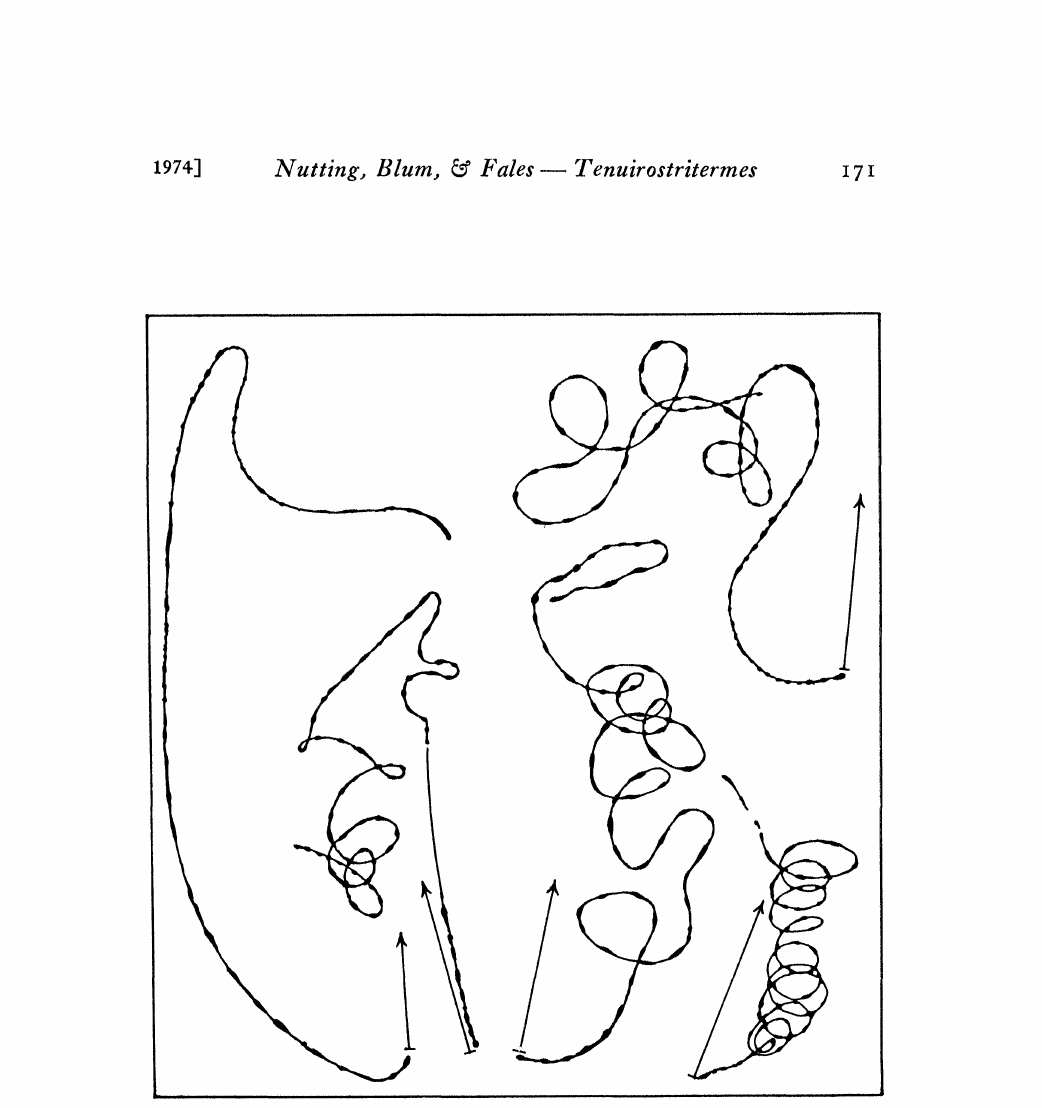
Fig. 1. Patterns of the threads of frontal gland secretion fired by five different soldiers of Tenuirostritermes tenuirostris at living ants fixed to glass slides. Arrows show direction of target and scale of